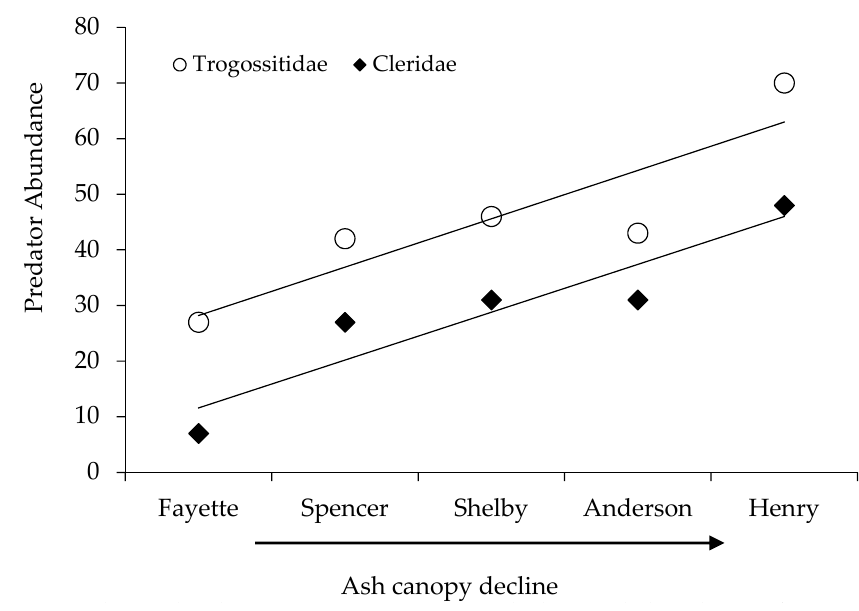
Figure 5. Relationship between Fraxinus canopy decline and abundance of two coleopteran predators: the Trogossitidae (Trogossitid abundance = 8.7 × canopy decline (%) + 19.5, R 2 = 0.71, p = 0.07) and the Cleridae (Clerid abundance = 8.6 × canopy decline (%) + 3, R 2 = 0.74, p = 0.06).